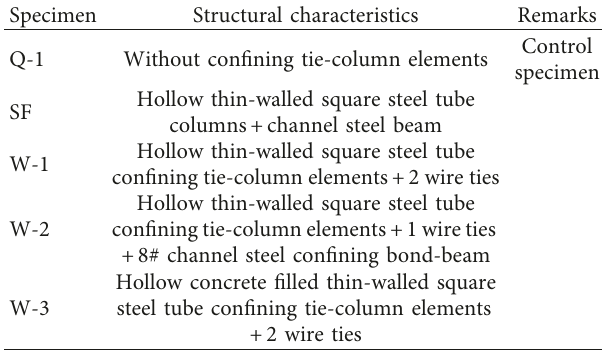
Table 3: Mechanical properties of wire ties, steel tube, and steel beam.